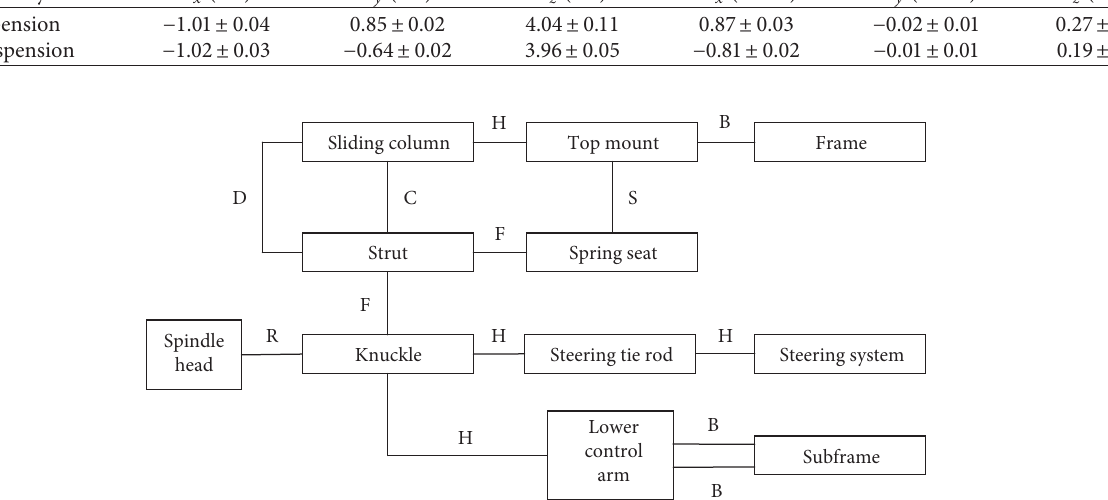
Figure 6: Topological relationship of front suspension assembly. B: bushing, H: hinge, S: spring, D: damping, R: revolute joint, F: fixed joint, and C: column joint.